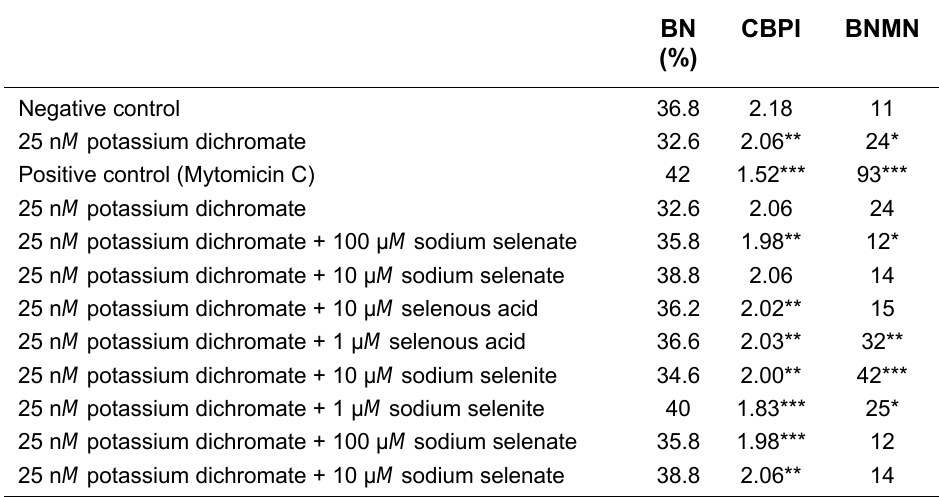
Assays Conducted with 25 n M Potassium Dichromate and Selenium Compounds in TK6 Lymphoblastoid